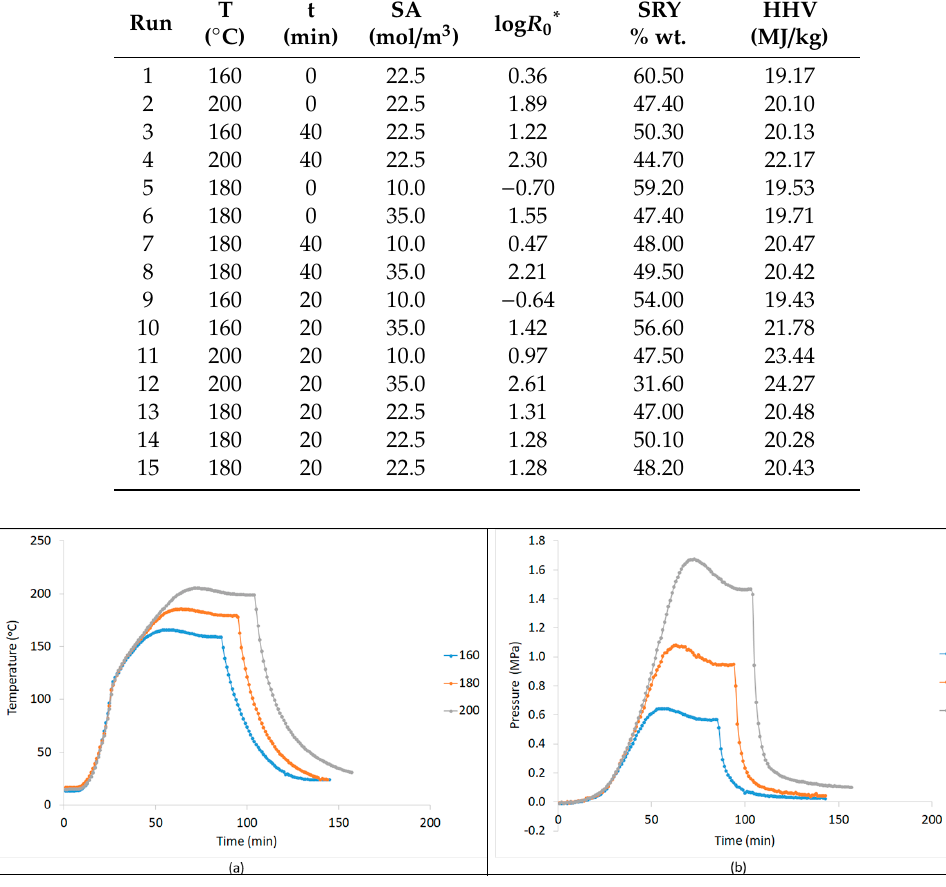
Figure 1. The ACWT pretreatment’s temperature ( a ) and pressure ( b ) profiles vs. time (isothermal period 40 min at 160, 180 and 200 ◦ C,